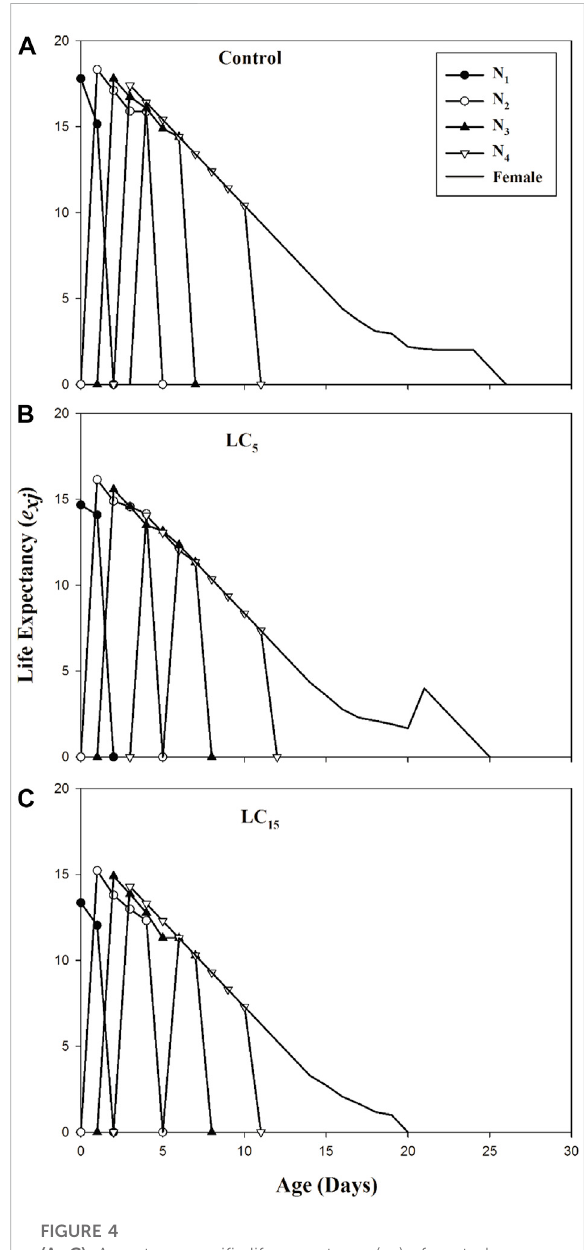
FIGURE 4 (A – C) : Age-stage speci fi c life expectancy (e xj ) of control group (A) and B. brassicae treated with LC 5 (B) and LC 15 (C) of Spirotetramat in F 1